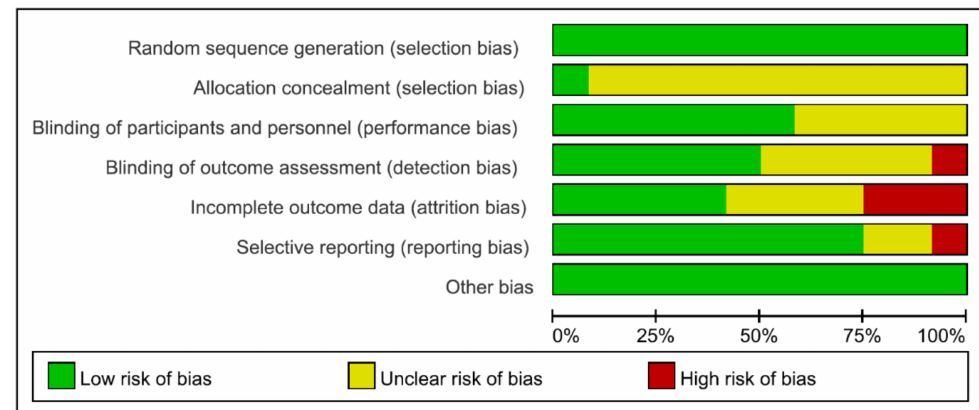
Figure 2. Risk of bias